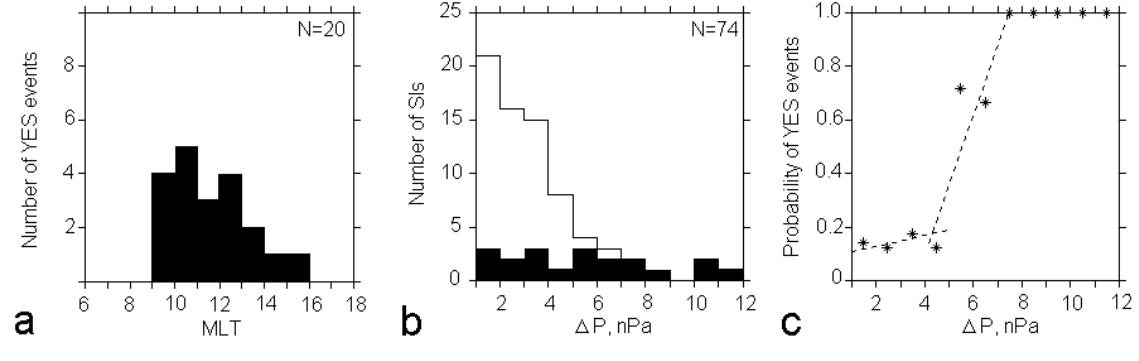
Fig. 5. (a) MLT distribution of “YES events”. (b) Number of SIs versus the SI intensity (SIs with ULF bursts after them are indicated with black). (c) Probability of “YES events” as a function of SI